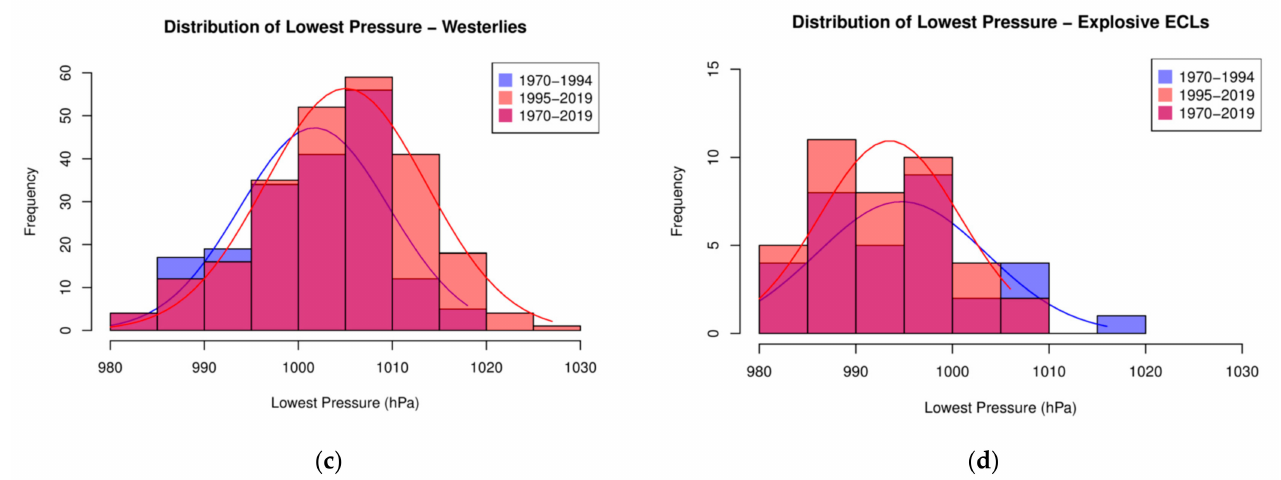
Figure 6. Histogram plots of ECL lowest central pressure distribution for periods April–September 1970–1994 and 1995–2019 for ( a ) Total, ( b ) Easterlies, ( c ) Westerlies, and ( d ) Explosives. Solid lines are the normal distribution interpolation of the